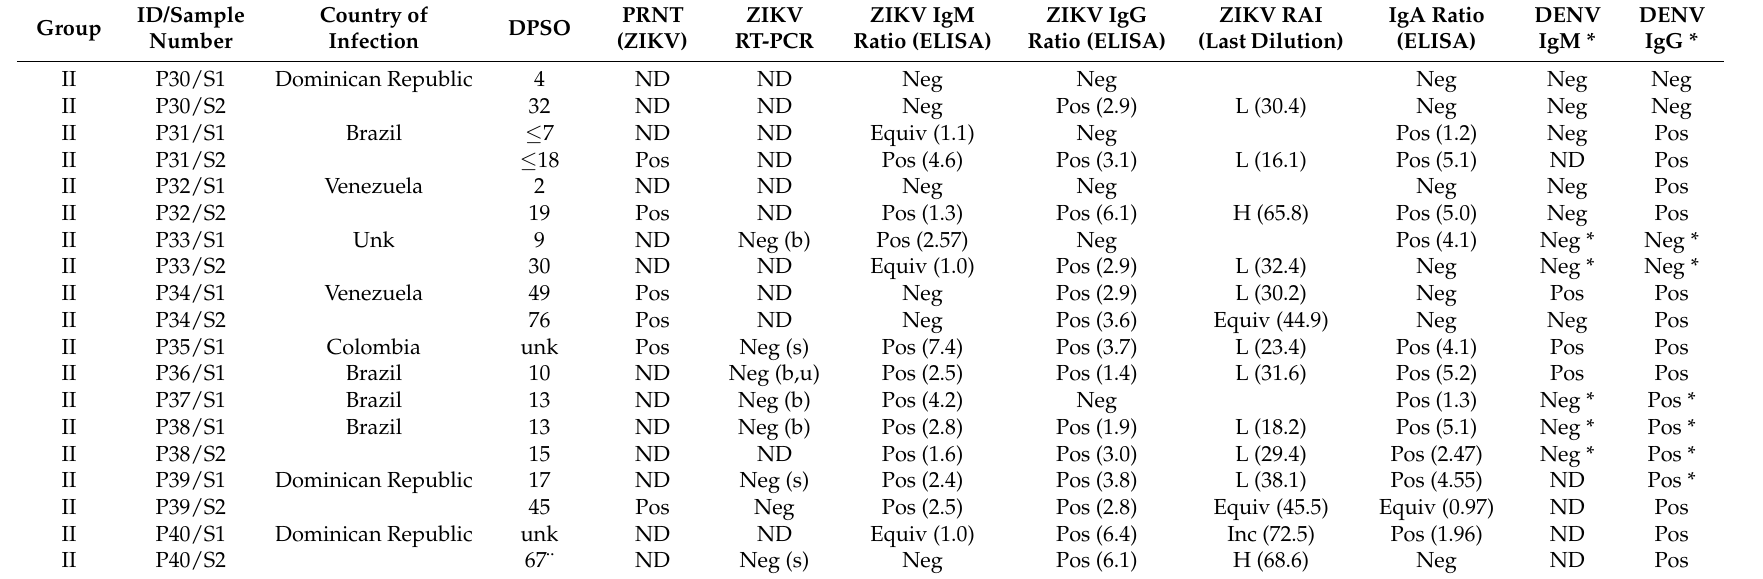
Table 2. Group II. Patients with serological suspicion of ZIKV